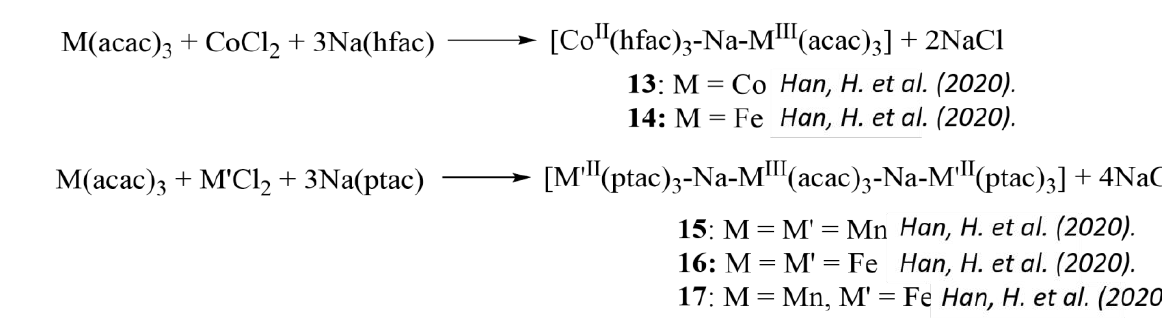
8 of 51 Figure 4. Molecular structure of 12 : (dik = ptac) [66]. Hydrogen atoms have been omitted, CF 3 groups of ptac are transparent for clarity. The cif has been retrieved from CCDC. CCDC number is 1518385. In the synthesis of polynuclear heterometallic complexes 13 – 17, alkali metal ions act as binders between two fragments of transition metal β -diketonates [67,68]. The initial reagents for these transformations are transition metals(III) β -diketonates based on acac, fluorine- containing sodium β -diketonates and chlorides of divalent 3d metal ions (Scheme 7, Figures